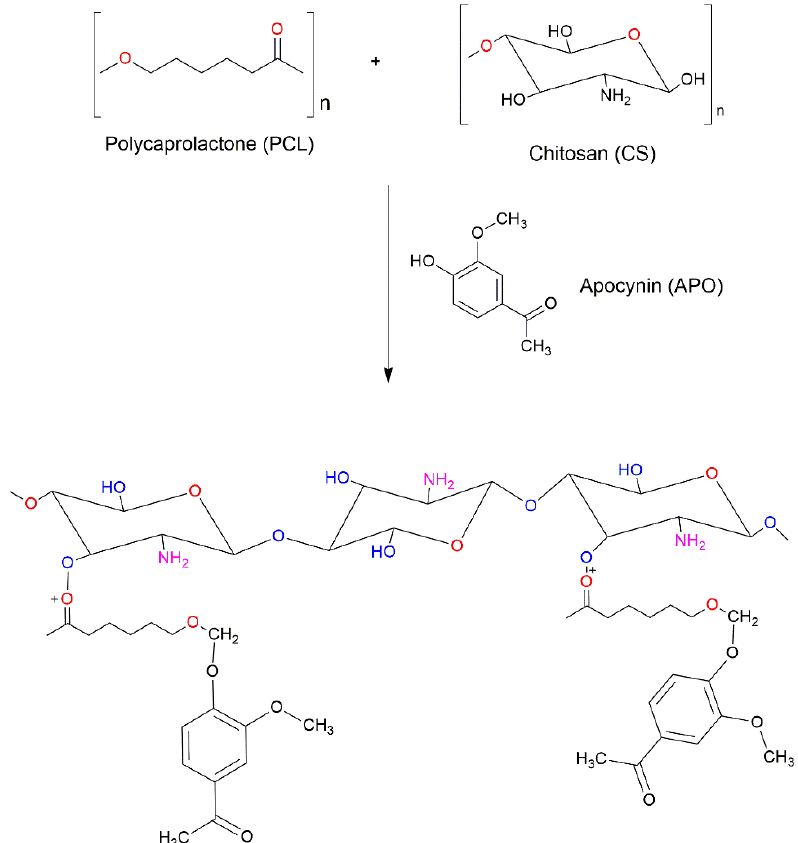
Figure 10. Lattice structure depicting the suggestive encapsulation of APO over the CS and PCL polymeric chain of NPs. polymeric chain of